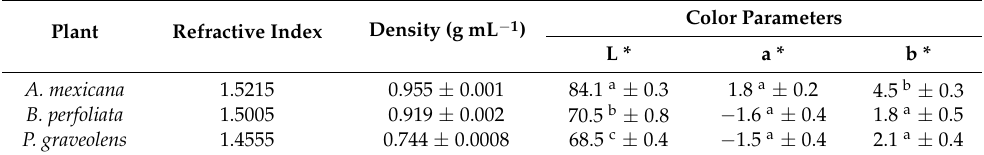
Table 1. Refractive index, density, and color parameters of essential oils.